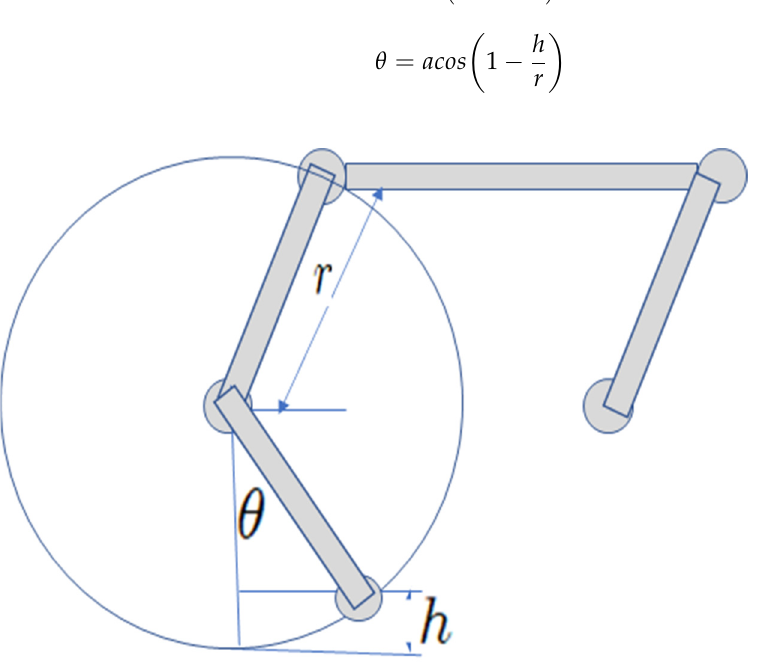
Figure 3. Kinematics of the four-bar link mechanism.